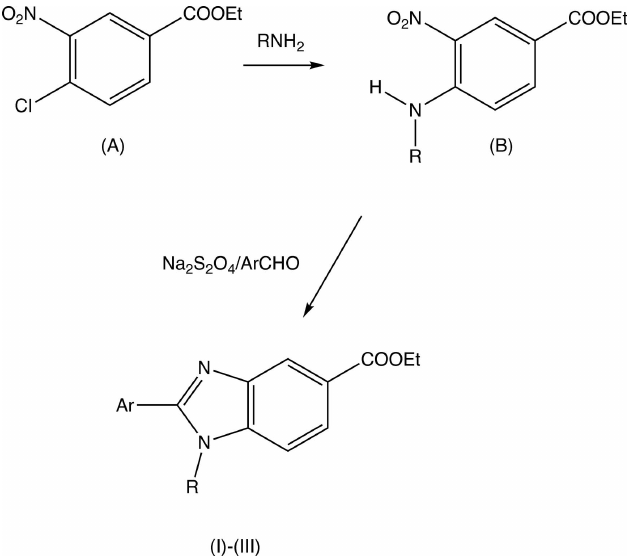
Figure 4 The synthetic pathway to compounds